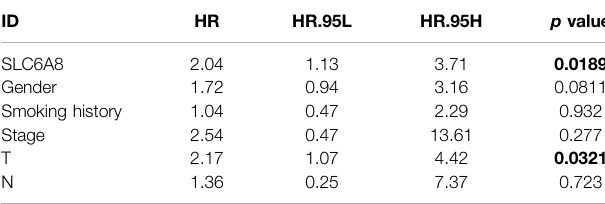
TABLE 2 | Multivariate cox analysis of SLC6A8 and clinical factors in LUAD.